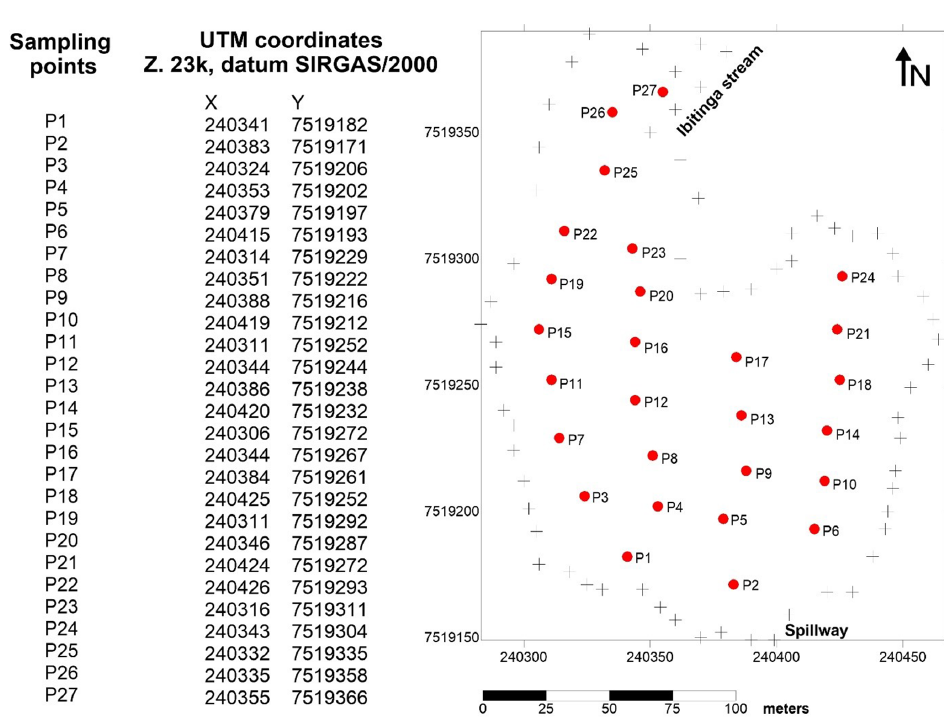
Figure 3. Sampling points distributed in a regular mesh in the FEENA reservoir.